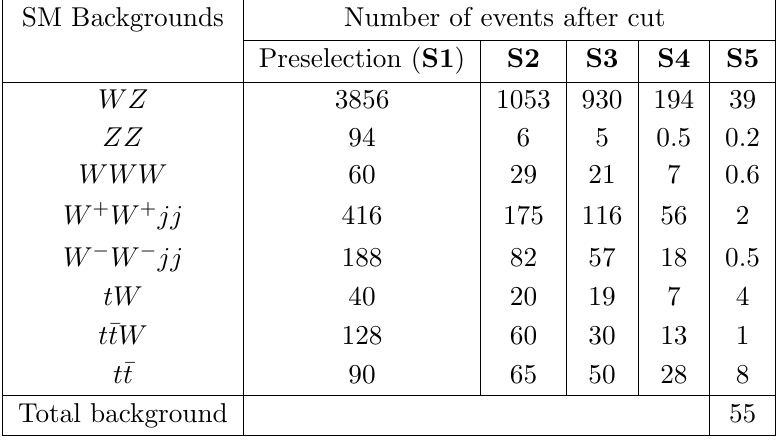
Table 13 . Same sign di-lepton + =E (cid:12)nal state number of events at 100 fb (cid:0) 1 for SM background. T Note that the events have been rounded-o(cid:11) to the nearest integer where relevant. Cross-sections scaled with K-factors at NLO [178] and wherever available, NNLO [191{196] have been